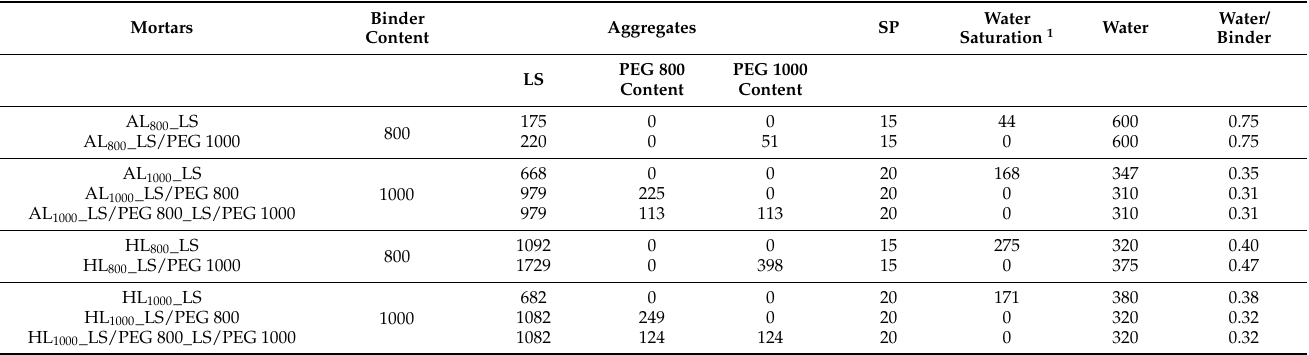
Table 1. Compositions of the produced mortars (reported as kg/m 3